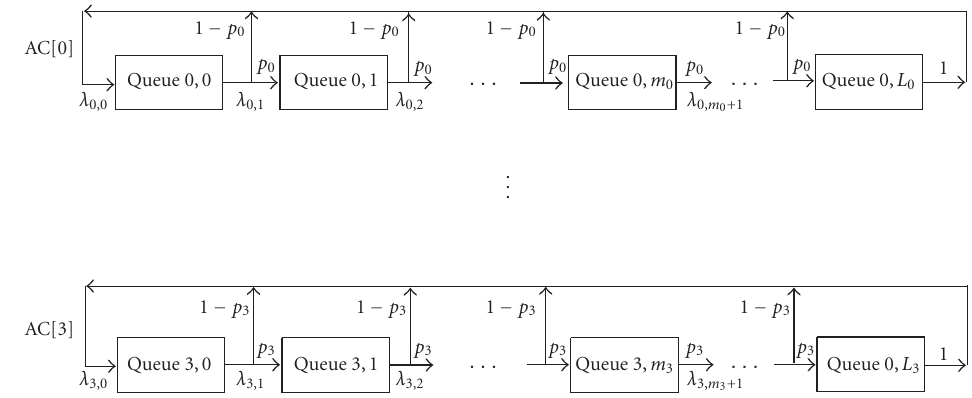
Figure 3: Queuing network model and analyzing the backo ff duration with Z